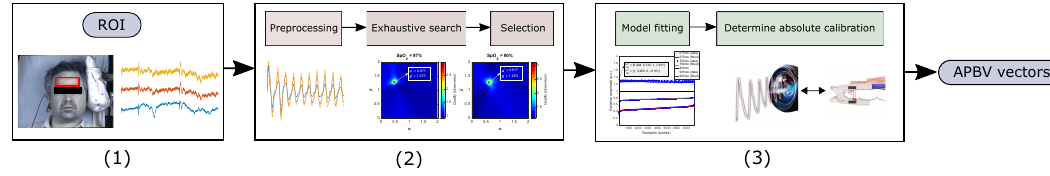
Figure 2. The general framework of our empirical calibration approach can be described by three steps: (1) extracting the raw PPG signals from the videos, (2) executing an exhaustive search over a range of pulse signatures using pulse quality as optimization criterion, and (3) fitting of a calibration model to the